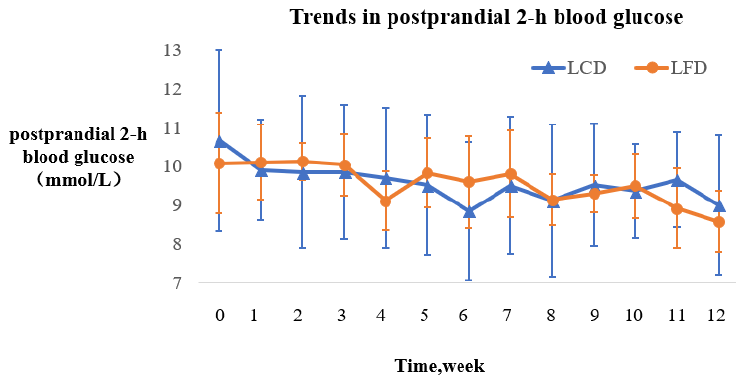
Figure 5. The changing trends of the postprandial 2-h blood glucose in the LCD and LFD Groups.